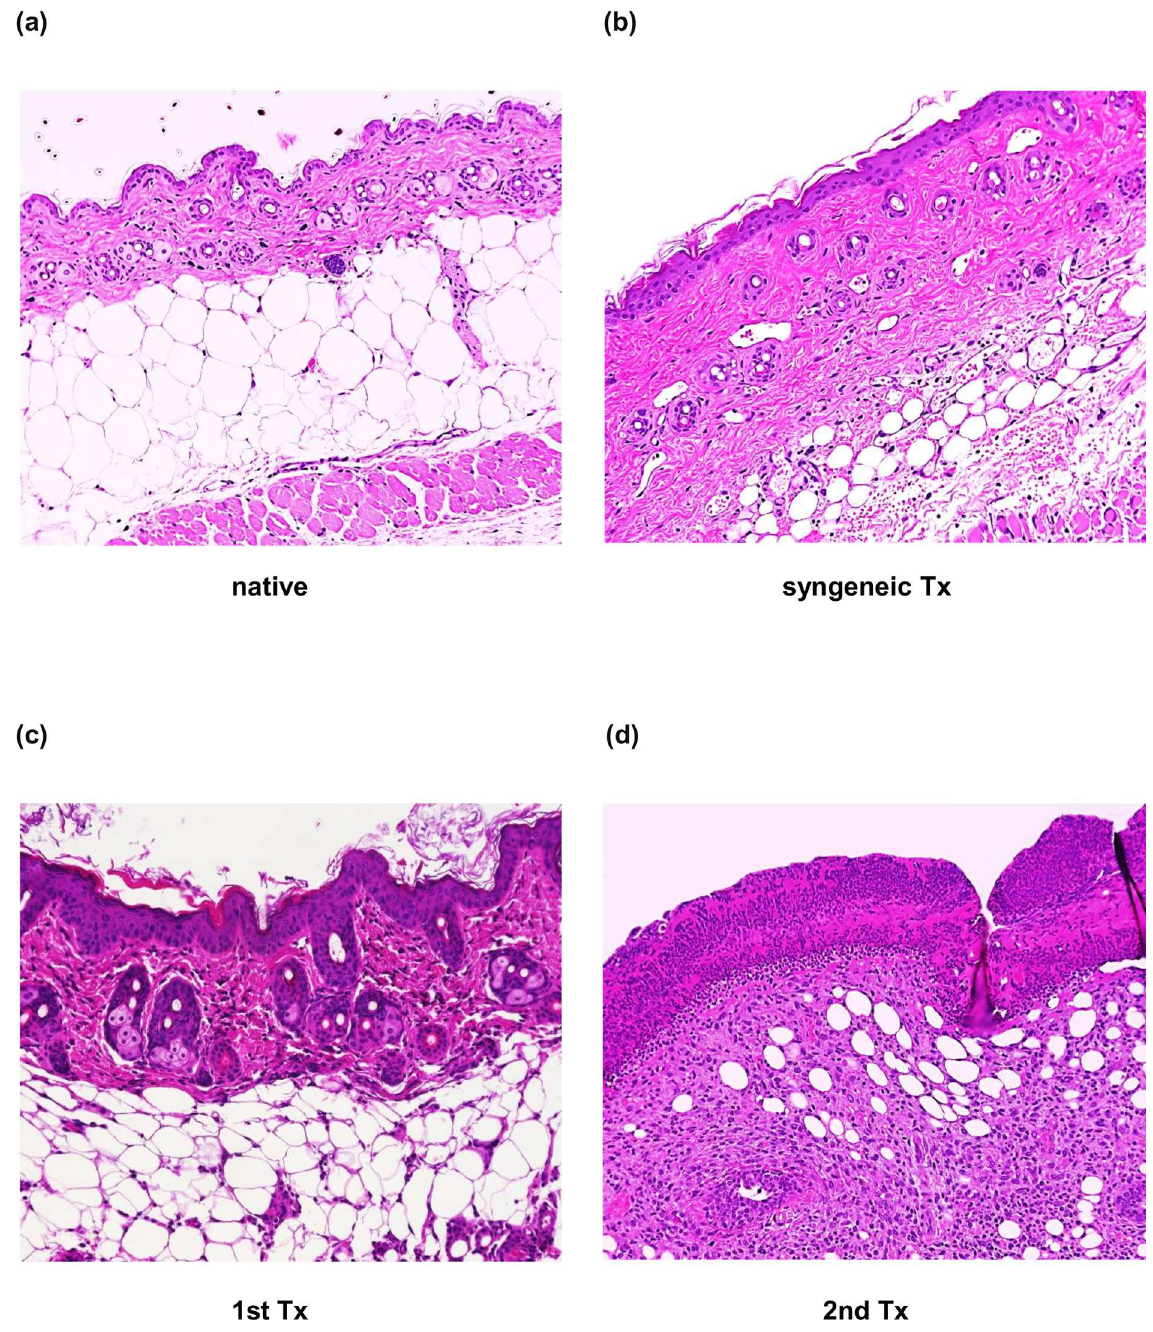
Fig 7. Histological examination of skin graftsat day 6 aftertransplantation. Skin graft specimenswere obtainedfroma native donorgraft (a),a syngeneictransplantrecipientmouse (SyngeneicTx, b), and allotransplanted mice with the first transplantation (1st Tx, c) and second transplantation (2nd Tx, d) on day 6. Paraffin sectionswere preparedand stainedwith hematoxylin and eosin. The syngeneicskin graft shows essentially normalhistology withoutintra-epithelial infiltratesor apoptoticepithelialcells. The allograft of the 1st Tx shows epidermalthickening and mononuclear cell infiltration slightlyinto the graft dermisand hair follicles. Degenerationand necrosis are observedin the epidermis and skin appendages are almostlost in the allograftof the 2nd Tx.